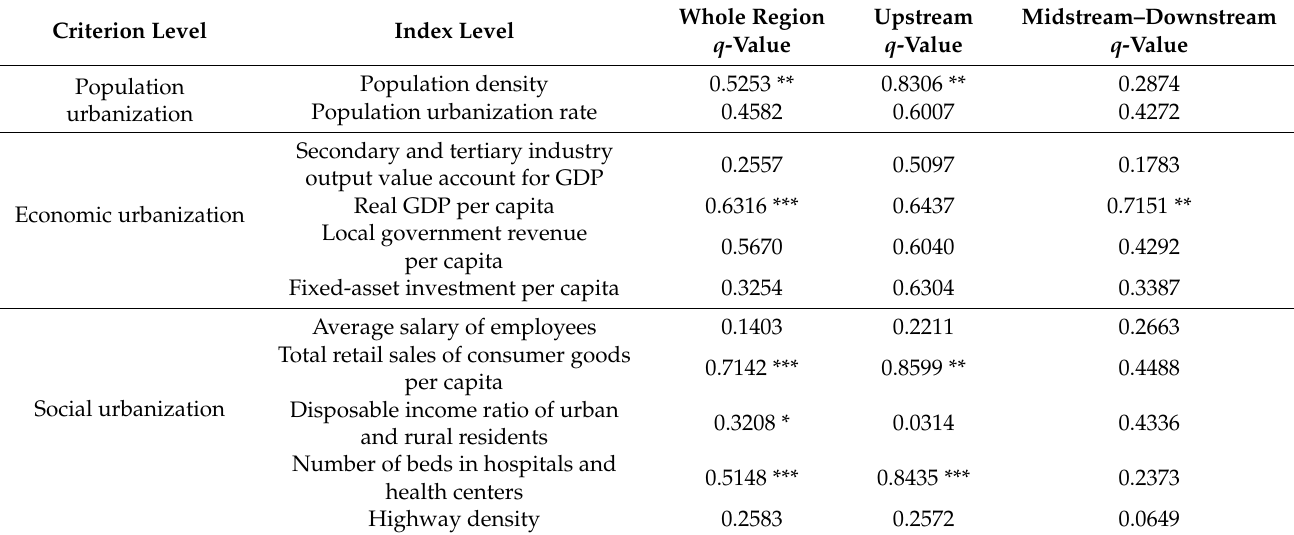
Table 4. The impact of urbanization factors on the internal mechanism of